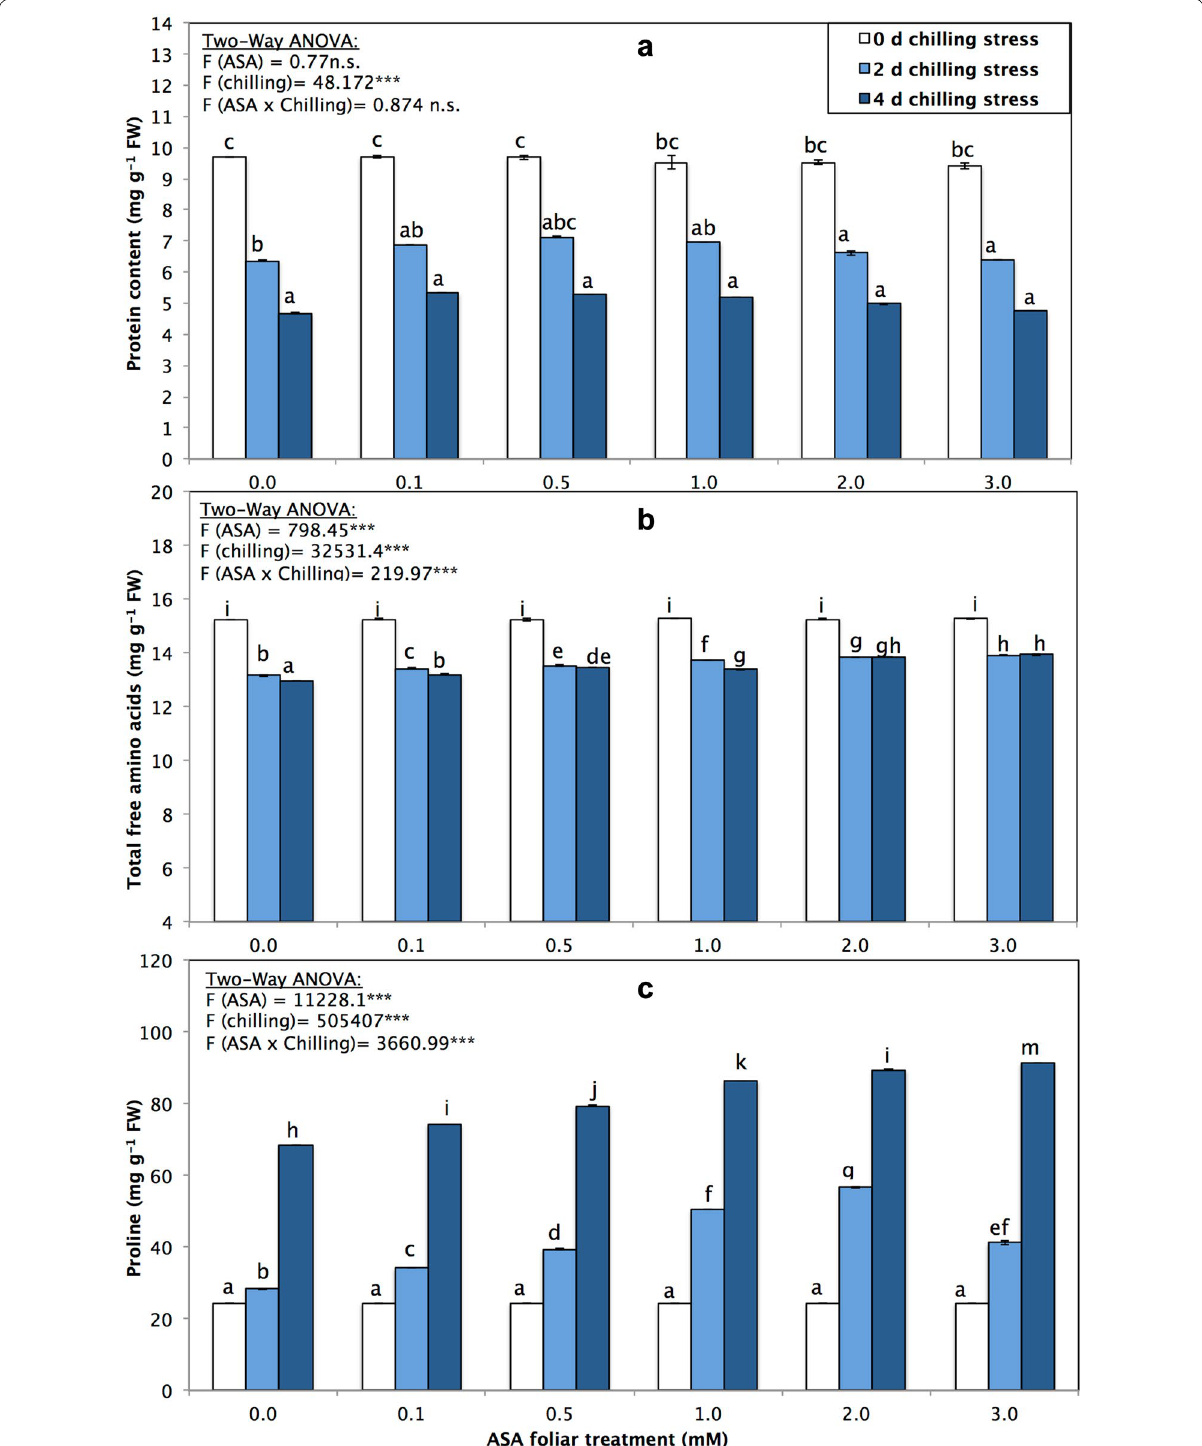
Fig. 2 a Protein content (mg g − 1 FW), b total free amino acids (mg g − 1 FW), c proline (mg g − 1 FW) of P. vulgaris L. after foliar application of different concentration of acetylsalicylic acid (ASA; 0, 0.1, 0.5, 1, 2, 3 mM) and exposed to different level of chilling stress (0, 2, 4 days). Data represented are mean of two replicates standard deviation. Variations between different chilling stresses and foliar ASA concentration were assessed by univariate ± analyses followed by post hoc analysis. Means with the same letters are not significantly different according to Duncan’s multiple